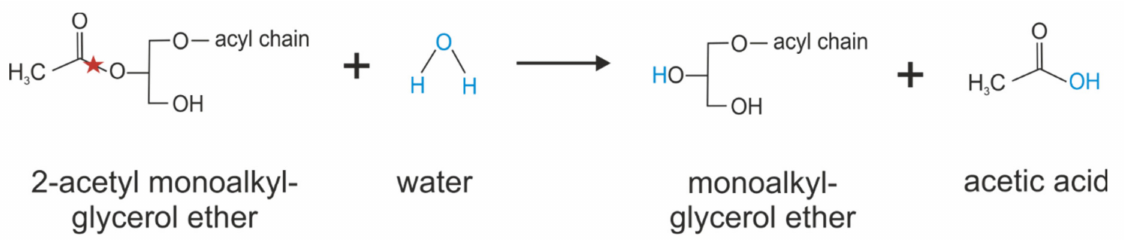
Figure 5. Catalyzing of 2-acetyl monoalkylglycerol ether hydrolysis by KIAA1363. Red stars indicate the bond that is